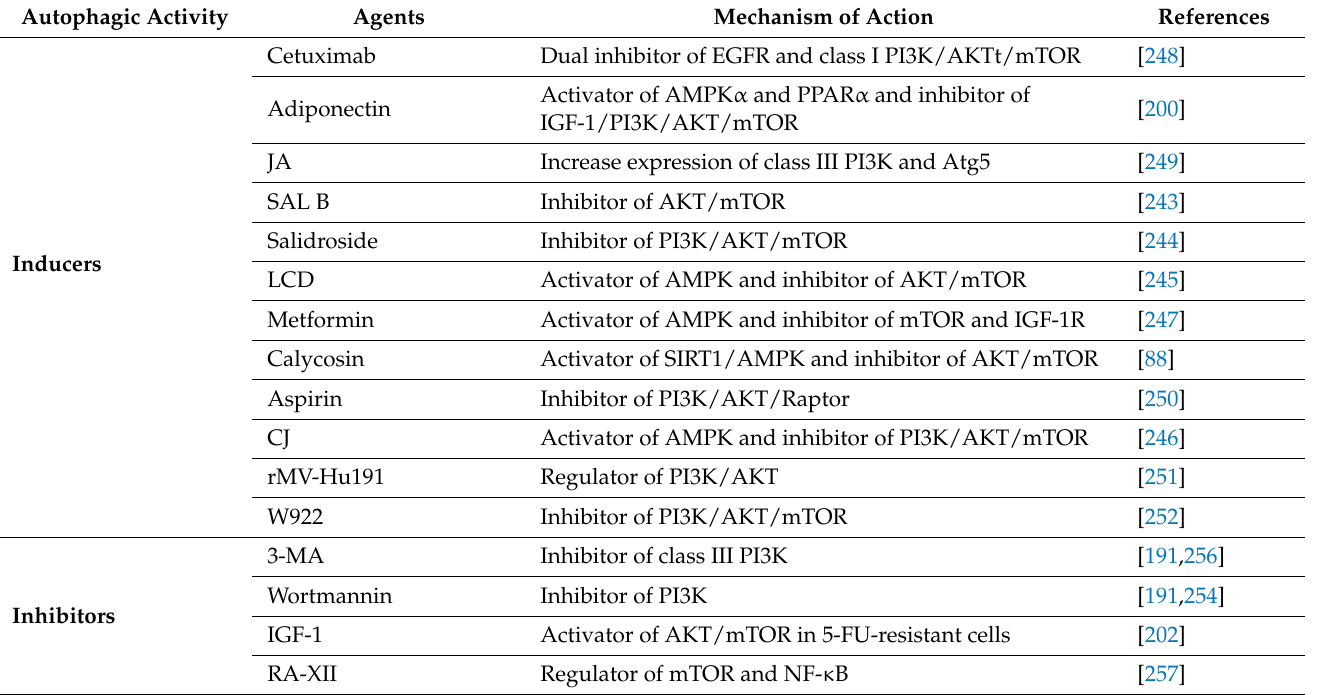
Table 3. List of chemotherapeutic strategies based on autophagic activity associated with IGF/IGF-1R signaling in colorectal